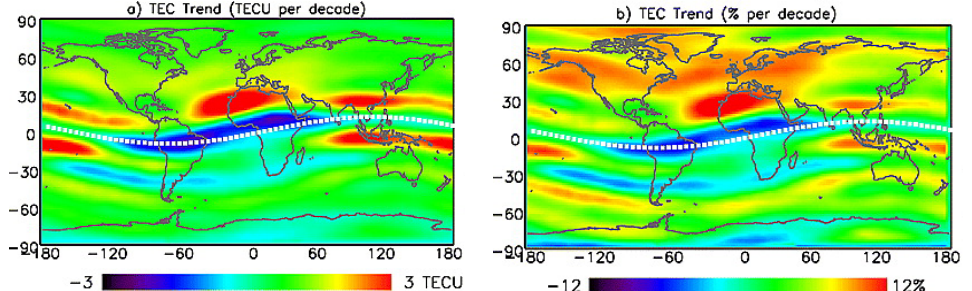
Figure 3. ( a ) The geographical distribution of 1998–2010 TEC trends obtained using the 3C model of EUV irradiance variability as absolute values in TEC units. The trend values have been normalized so that the global mean trend is +0.6 TECU per decade (the average of the 1995–2010 global trends using the 2C and 3C models). ( b ) Percentage changes relative to the average ionosphere. (Reproduced from Lean et al. [56]: Figure 7, modified. See [56] for details on EUV (extreme ultraviolet) modeling).